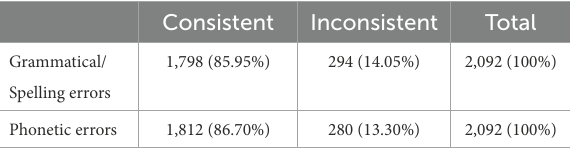
TABLE 5 Automatic evaluation results on 1,009